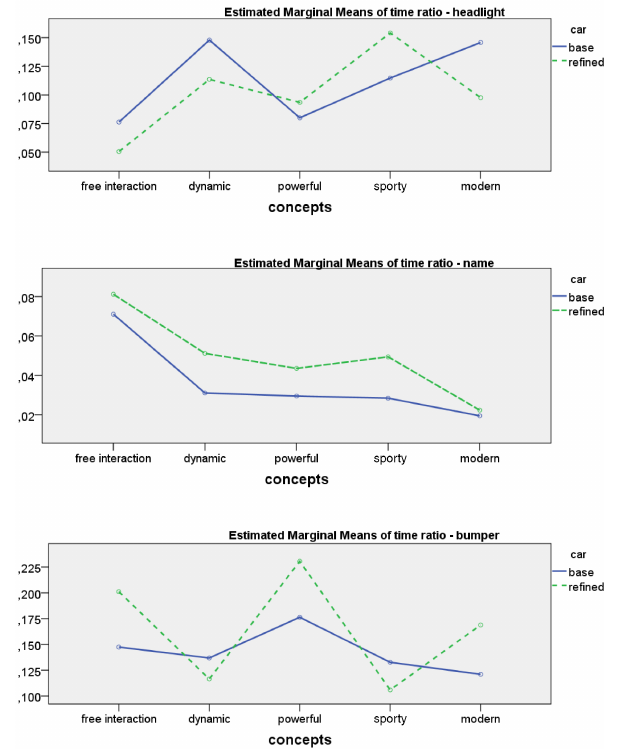
Figure 5. Means of time ratio for left headlight, name and bumper.